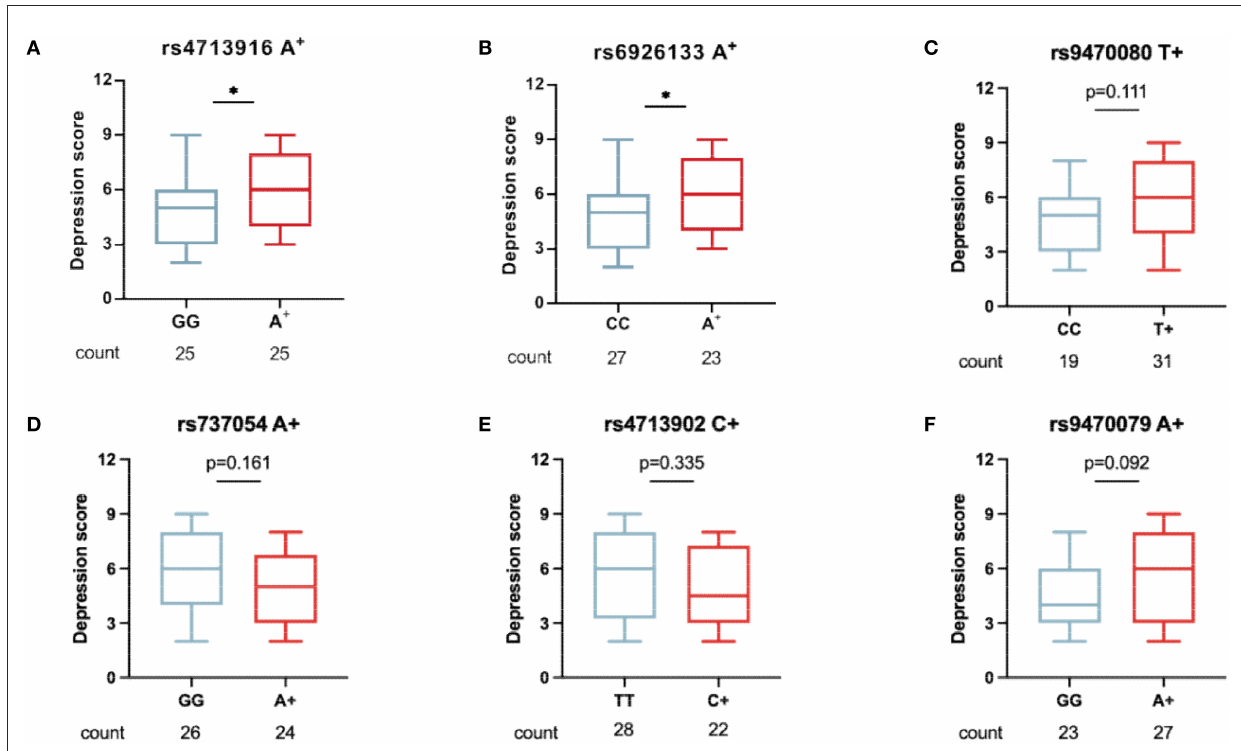
FIGURE3 The association of the six FKBP5 SNPs with DD severity in patients with MAUD. In 50 patients with DD who had comorbid MAUD, the association of the minor alleles of FKBP5 rs4713916 (A) , rs6926133 (B) , rs9470080 (C) , rs737054 (D) , rs4713902 (E) , and rs9470079 (F) with the depression scores was measured. Patients carrying FKBP5 rs4713916A or rs6926133A had greater depression scores. * p < 0.05, n.s., no significance. Mann–Whitney U -test. MAUD, methamphetamine use disorder; DD, depressive